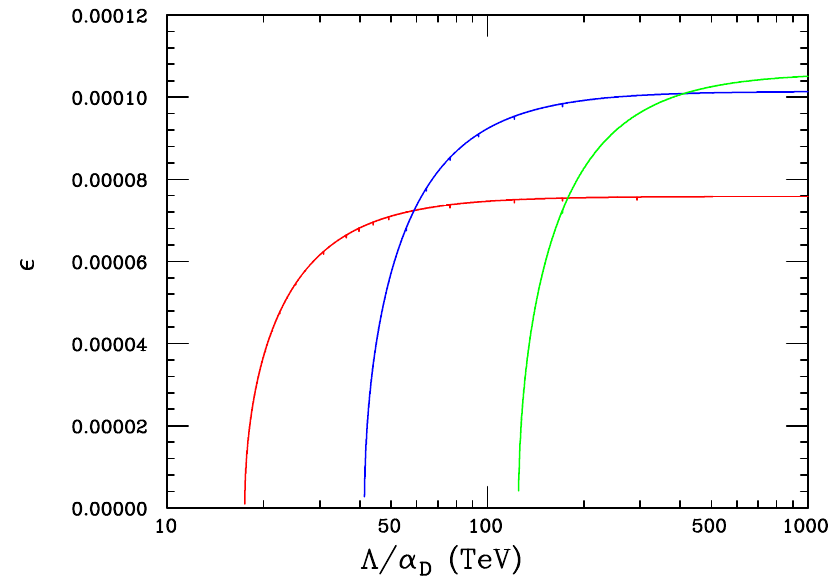
Figure 4 . Correlated values of (cid:15) and Λ e /α D assuming both KM and the dark dipole magnetic moment contribute to the DM annihilation cross section yielding the observed relic density assuming that r = 0 . 8 and m V = 200 MeV for purposes of demonstration. The red(blue, green) curves assume that α D = 1(0 . 1 , 0 . 01) ,